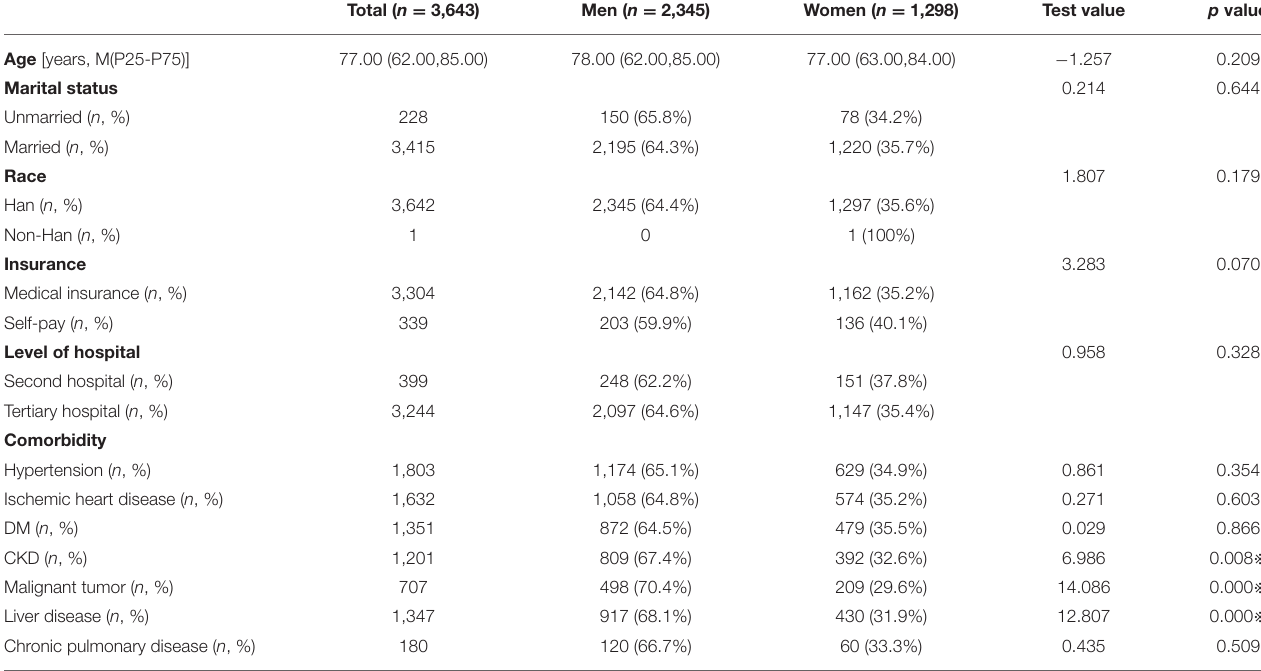
TABLE 1 | Clinical characteristics of the septic shock patients at discharge.